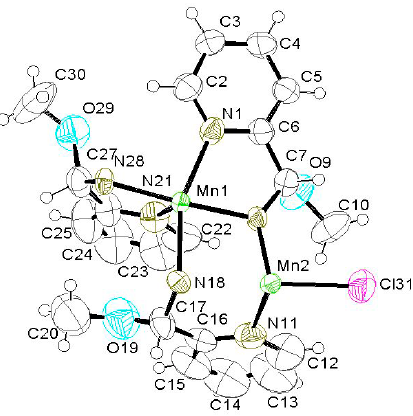
Figure 4. ORTEP view for the asymmetric unit for 2 with atoms showing the atomic numbering scheme.